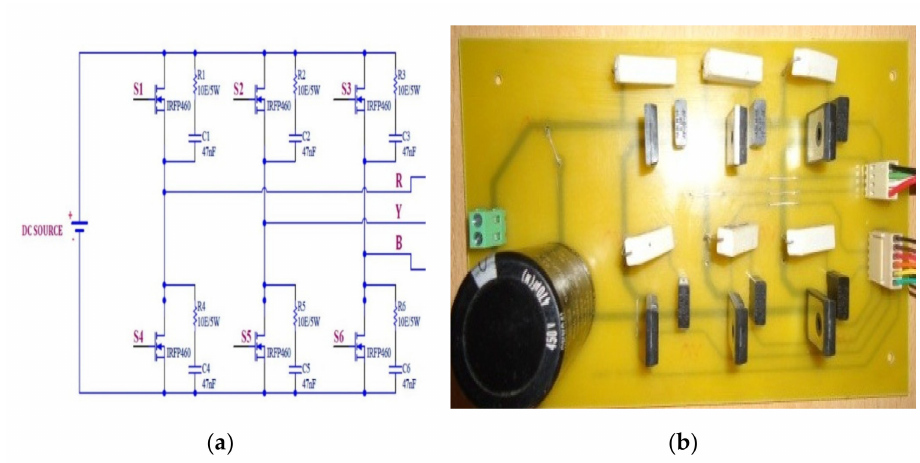
Figure 16. ( a ) Schematic circuit of the three-phase inverter; ( b ) a real photograph of the inverter.